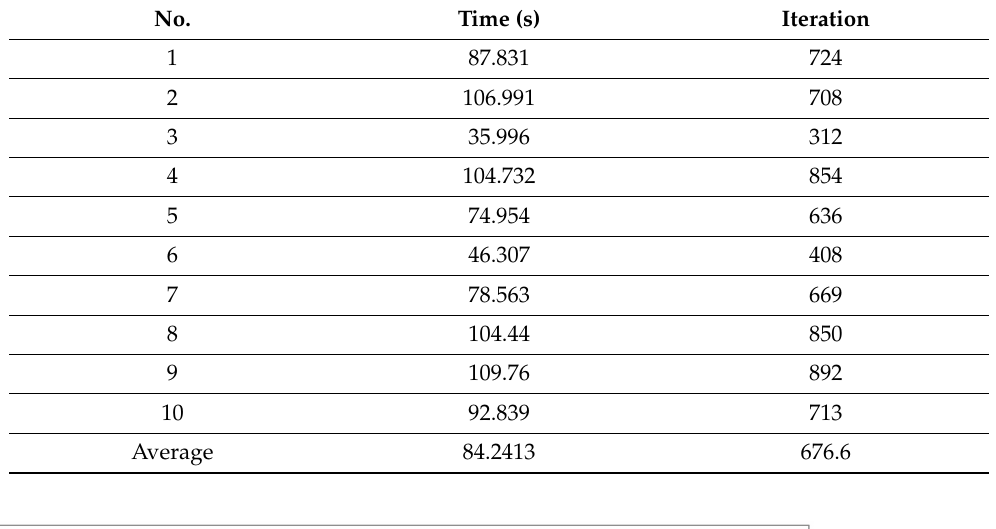
Table 3. Average time and iteration.